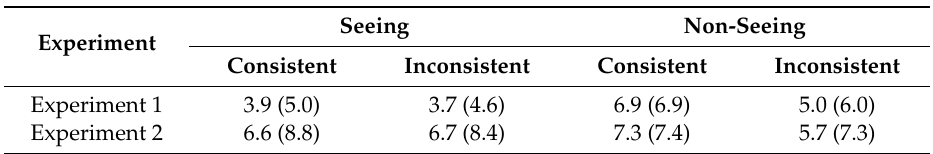
Table 1. Percentage of errors and standard deviations (in parentheses) in each condition of Experiments 1 and 2.